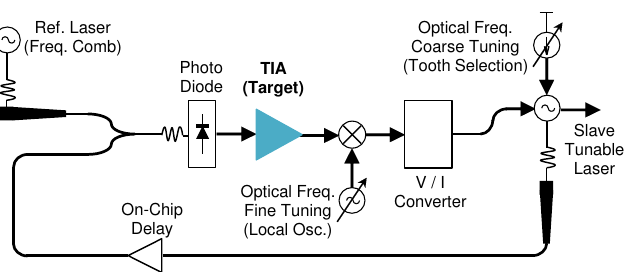
Figure 1. Block diagram of a optical heterodyne receiver (modified in [9]).